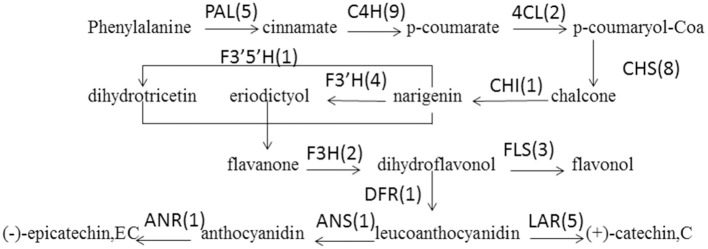
F. dibotrys unigenes involved in flavonoid biosynthesis. The number in bracket following each gene name indicates the number of corresponding F. dibotrys unigenes.